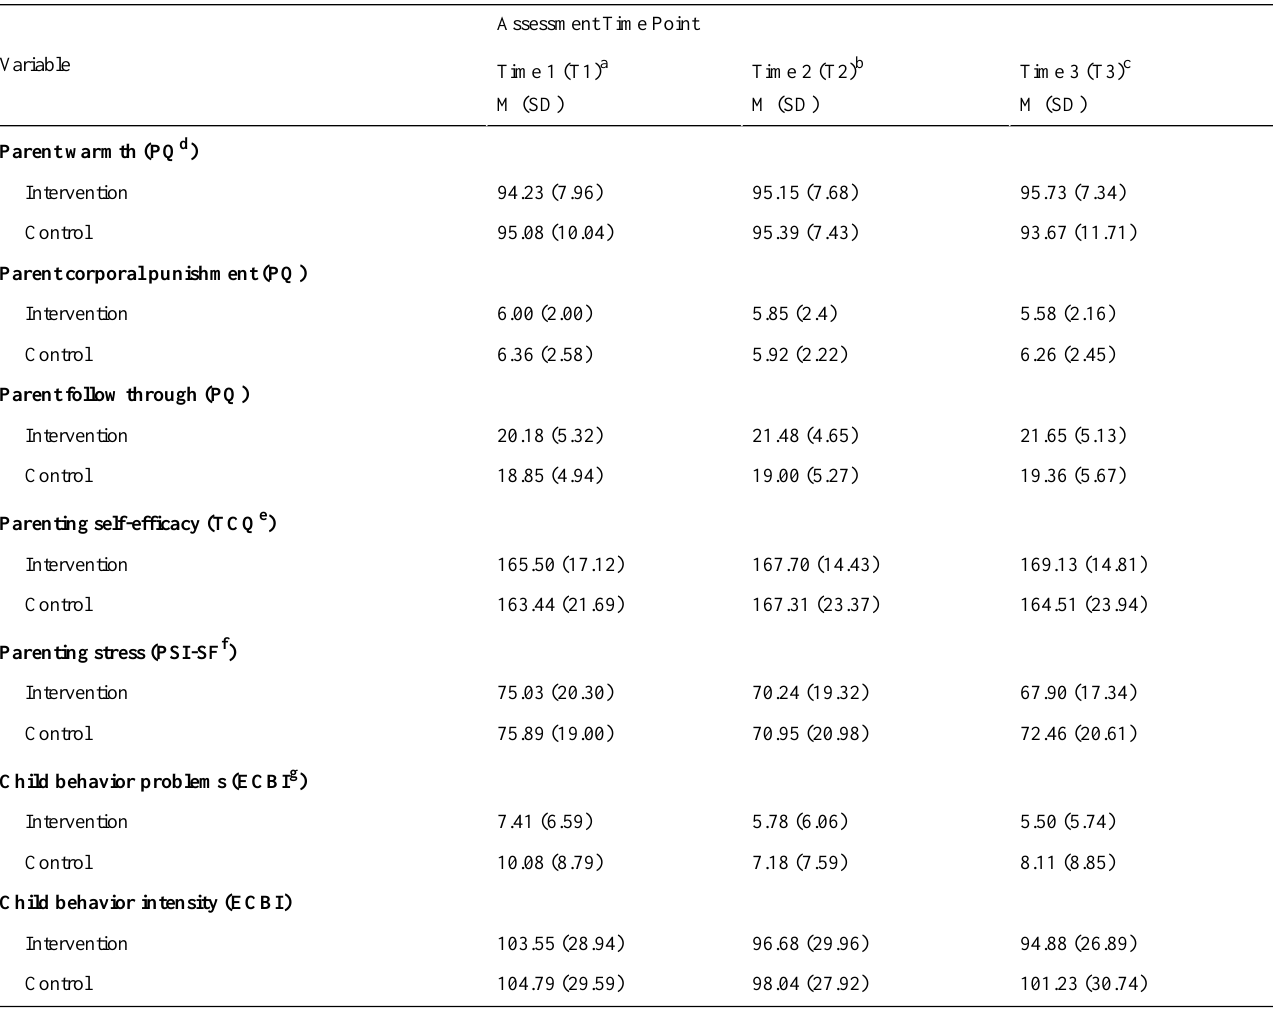
Table 3. Mean and standard deviation of outcome variables for intervention (n=40) and control (n=39)